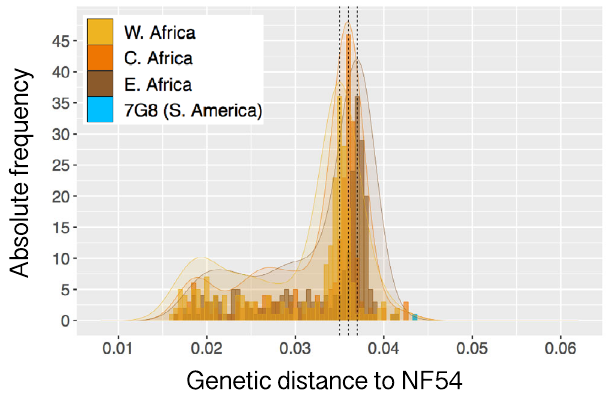
Fig. 1 Pairwise genetic distance of 704 Pf African isolates and of Pf7G8 to NF54, the Pf strain in PfSPZ Vaccine. Histogram shows the proportion of 137,585 variable sites that differ between Pf isolates from West (yellow), Central (orange), and East (brown) Africa and NF54 ( X -axis). The Y -axis represents the count of isolates for each genetic distance. For improved visualization, a Gaussian kernel density plot is overlaid on the histograms (shaded). The increasing genetic distance, from West to East, of African isolates to NF54 is expected, since NF54 is thought to originate from West Africa 31 . The pairwise genetic distance between NF54 and the Brazilian clone 7G8 (blue) is larger than the distance of any African isolate and